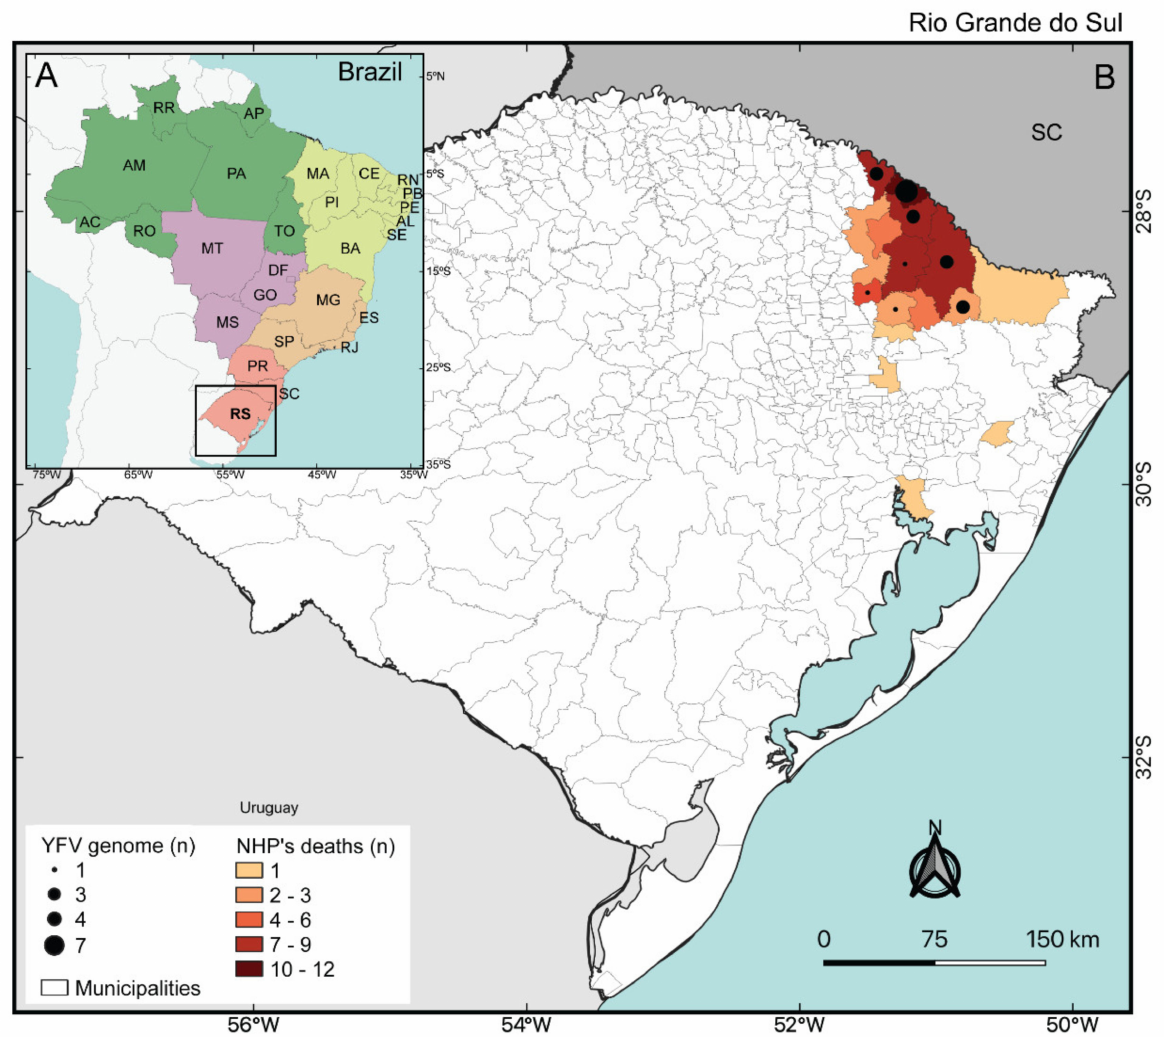
Figure 1. ( A ) Brazilian regions: North (green); Northeast (yellow); Central-West (purple); Southeast (orange); South (red). ( B ) Geographical distribution of YFV NHP cases in Rio Grande do Sul. The municipalities with NHP deaths positive at RT-qPCR are highlighted. Numbers of genomes recovered per municipality are illustrated by black